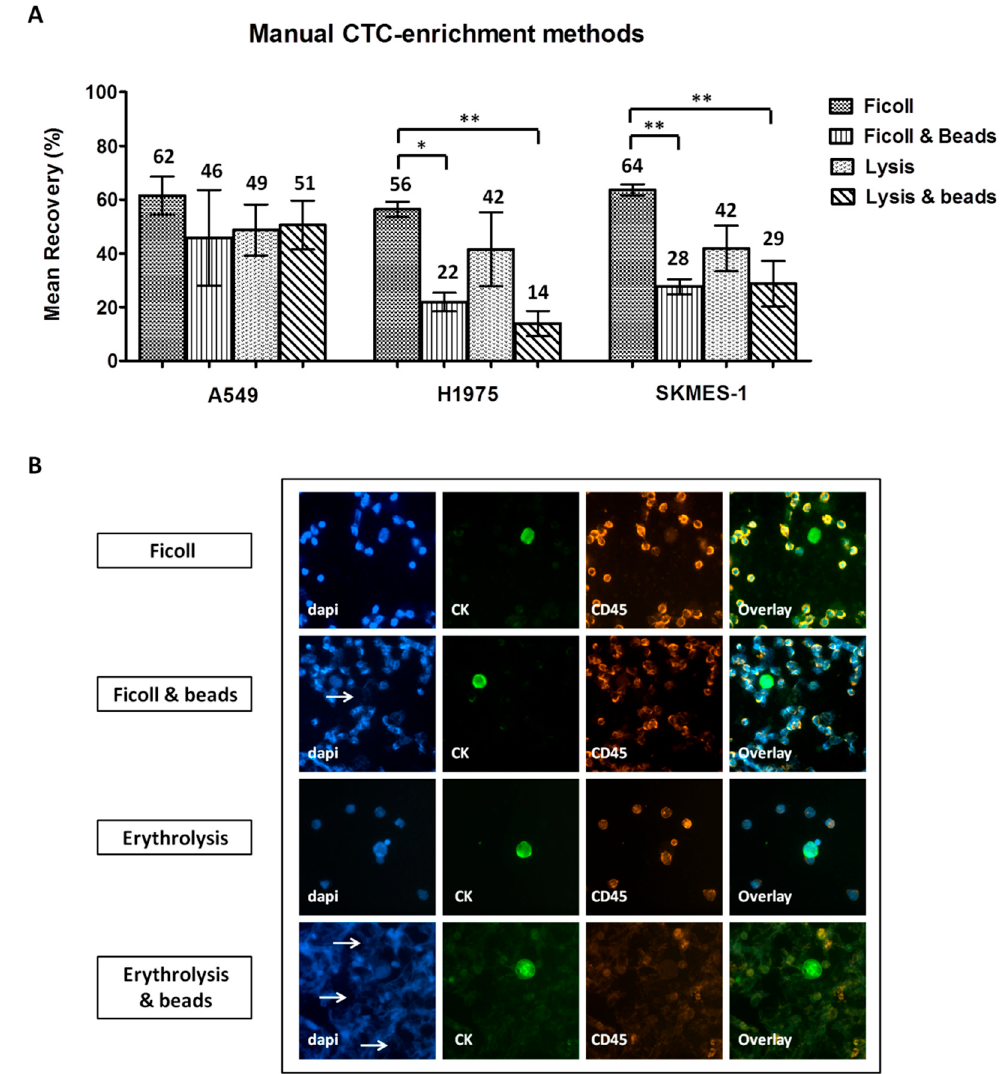
Figure 2. Comparison of manual circulating tumor cell (CTC)-enrichment approaches in spiking experiments: ( A ) Recovery rates of pre-labeled A549, H1975, and SKMES-1 cells following enrichment with each method. Values represent mean recoveries; error bars represent standard error of mean (SEM). * , ** One-way ANOVA test; statistical significance at the p < 0.001 level. ( B ) Representative staining of DAPI / CK / CD45 on spiked non-pre-labeled H1975 cells enriched using di ff erent methods (Ariol microscopy system, Genetix, New Milton, UK) (200 × ). Nuclear fragmentation indicated by arrows.